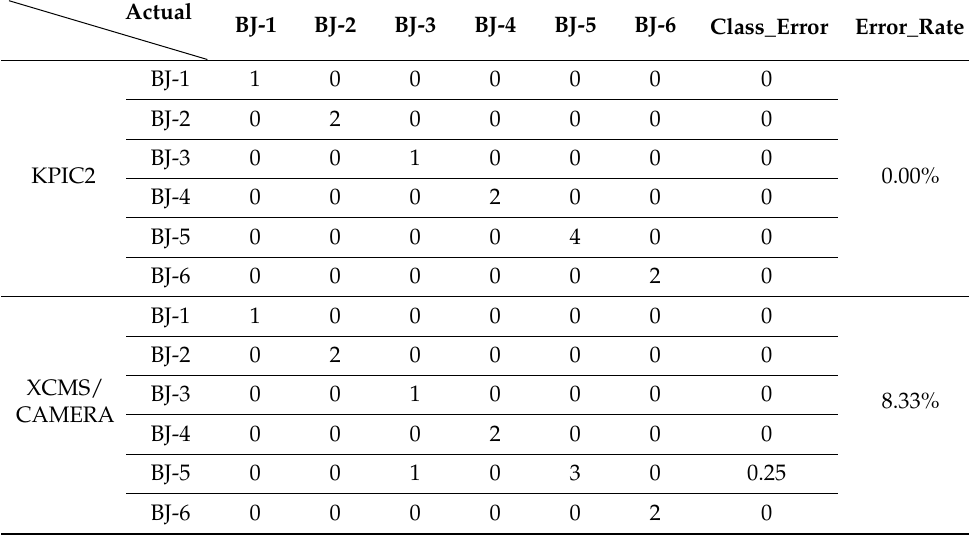
Table 2. Classification results of the liquor dataset on the test sets.